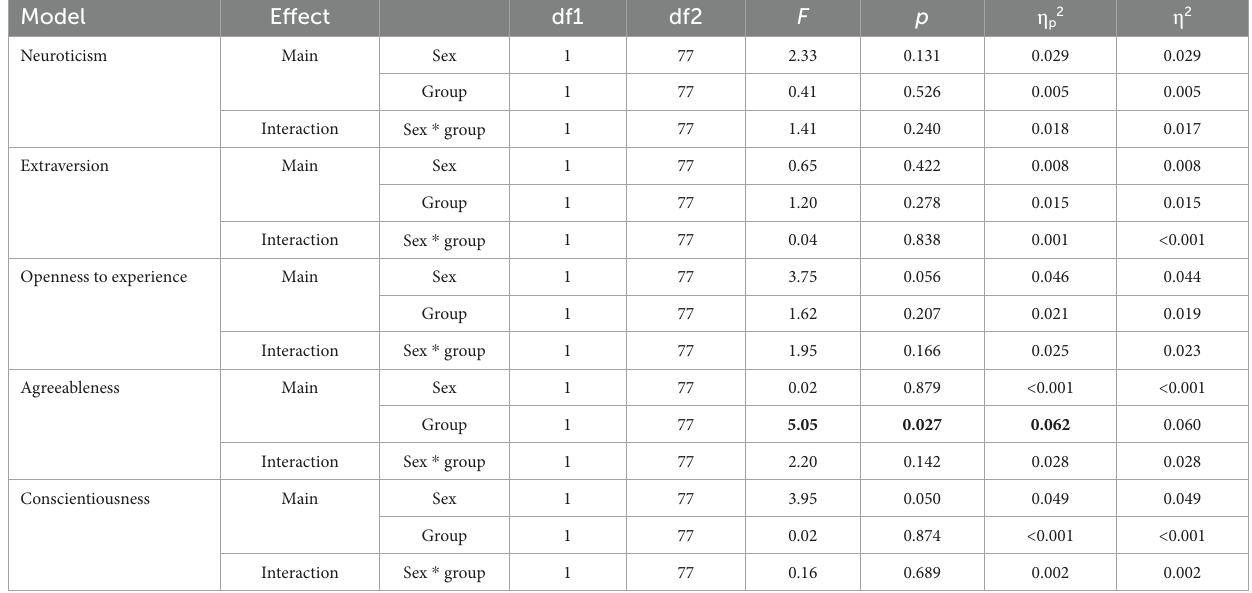
TABLE 3 Coefficients of the two-factor analysis of variance model for individual personality traits. Model